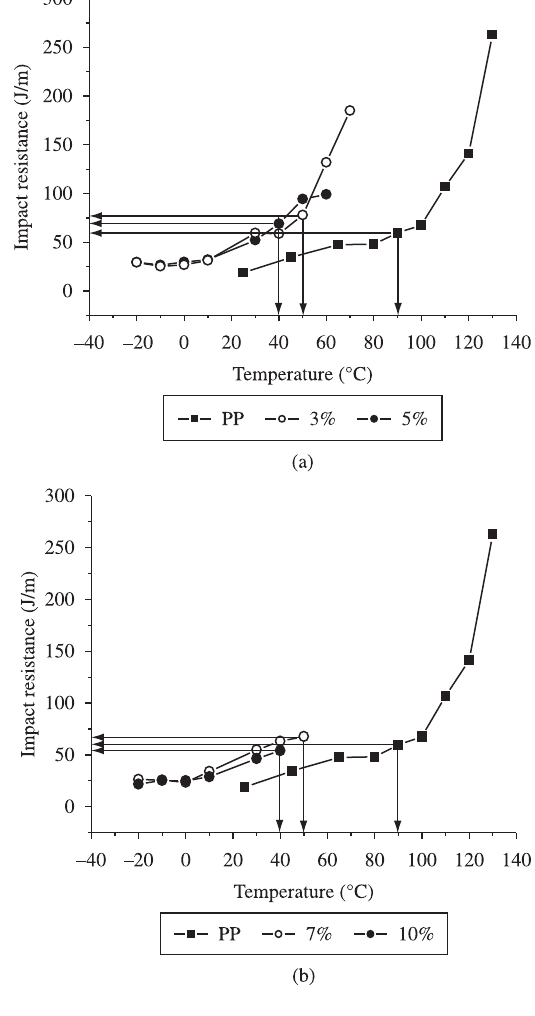
Figure 8. Impact resistance of neat PP and PP/CaCO temperature.